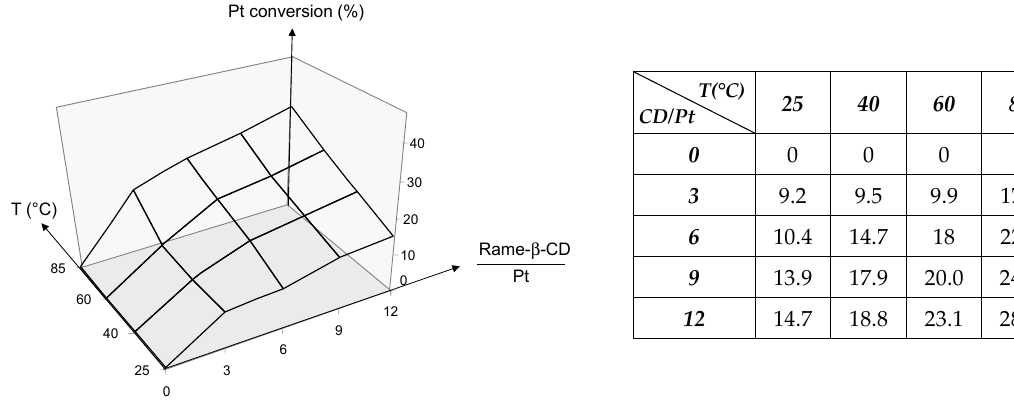
Figure 7. [Pt(TPPTS) 3 Cl]Cl conversion (%) into cis -PtCl 2 (TPPTS) 2 as a function of RAME- β -CD quantity and temperature, [Pt] = 10 mM, D 2 O.